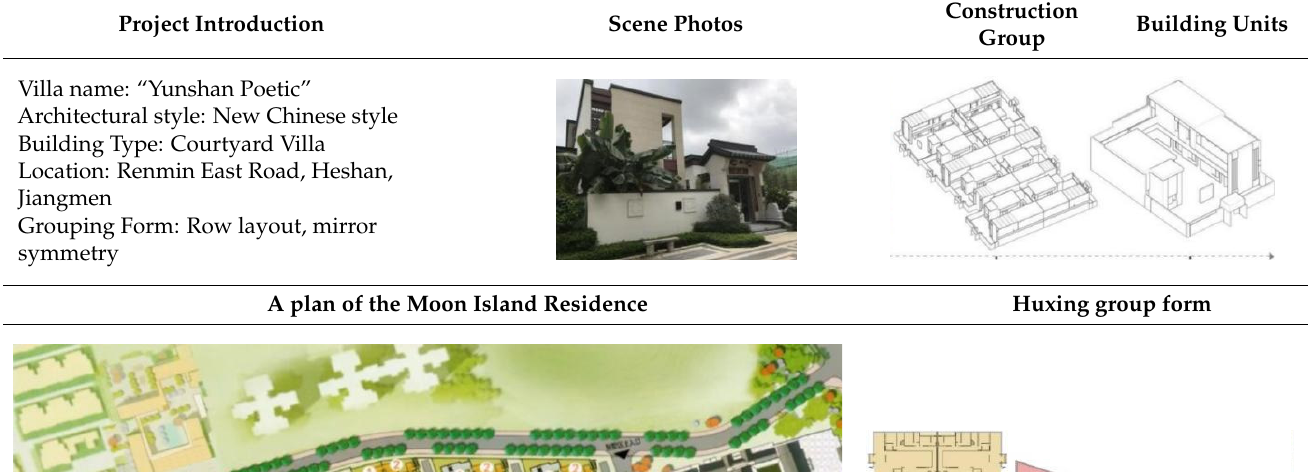
Table 1. Profile of the Moon Island Residence.